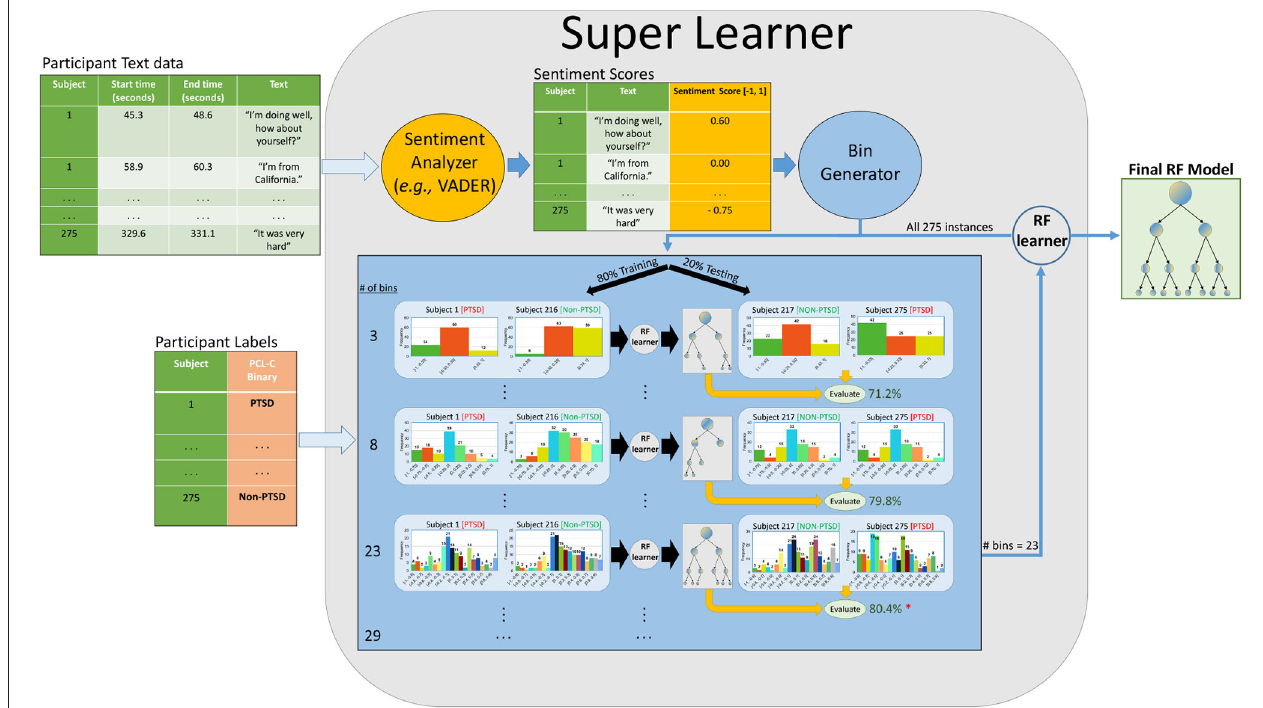
FIGURE 2 | Sentiment analysis pipeline. A simplified version of our pipeline. Raw text is given to a sentiment analyzer (i.e., VADER/Textblob/Flair) that outputs a compound scalar score between [ − 1, 1] for each utterance. Note that each participant provides many such utterances in the session; our SuperLearner (SL) then bins that participant’s set of scores into a set of k bins. It uses internal cross-validation (on the training set) to identify the optimal number of bins and tune hyperparameters. Here, it found that 23 bins was optimal. We repeat this process with different partitioning methods with our dataset, such as five-fold-CV and the original train-test folds. We also consider four different base learners, though our figure only shows the RF learner [Linear Discriminant Analysis (LDA), Support Vector Classifier (SVC), and Random Forests (RF), and Gradient Boosting (GB)].